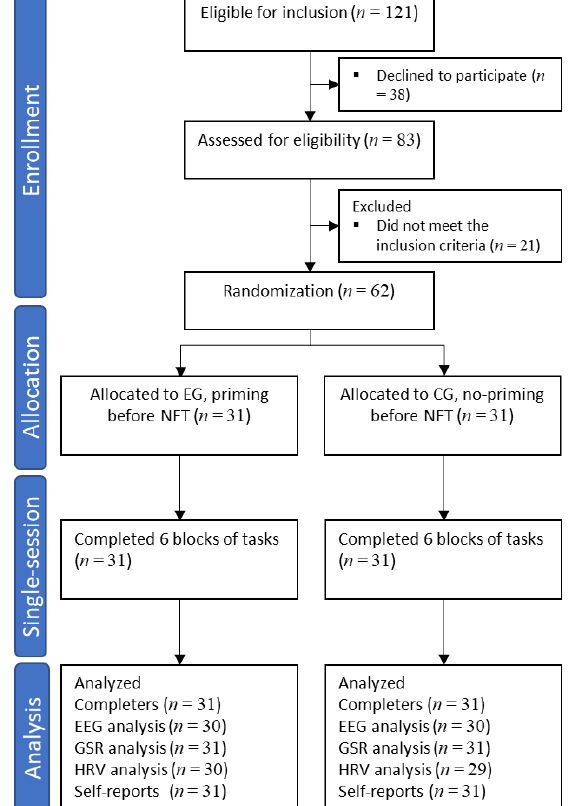
Figure 1. Consort flow diagram of the randomized controlled intervention. Of the 121 participants eligible for inclusion, 38 declined to participate, and 21 did not meet the inclusion criteria. Sixty-two participants were randomized and allocated to the priming and no-priming group. There were no dropouts, and all the subjects completed the tasks. During analysis, missing data from subjects in EEG and HRV were detected, and one CG subject with outlier EEG data was removed.